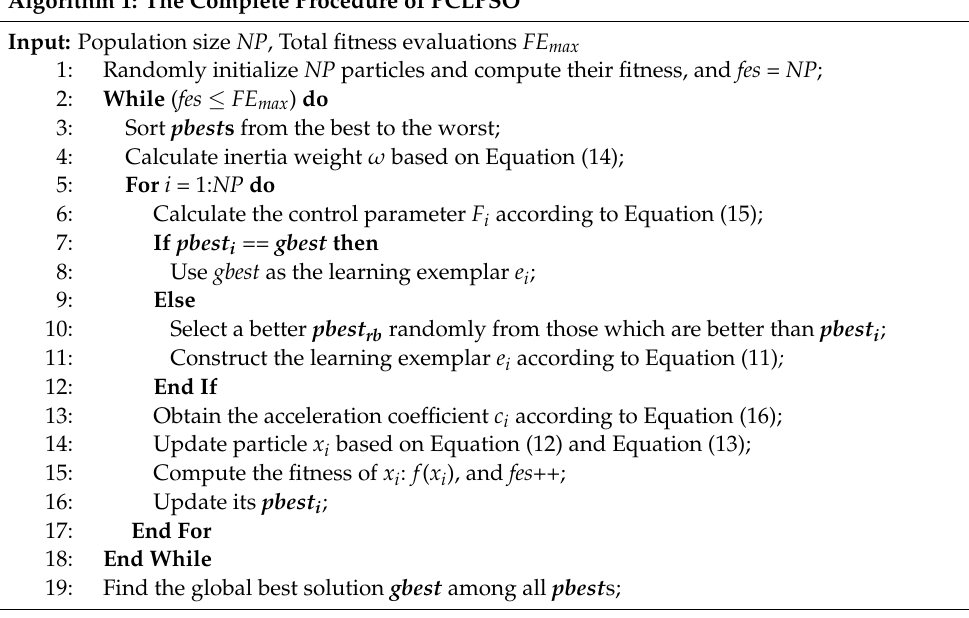
Algorithm 1: The Complete Procedure of